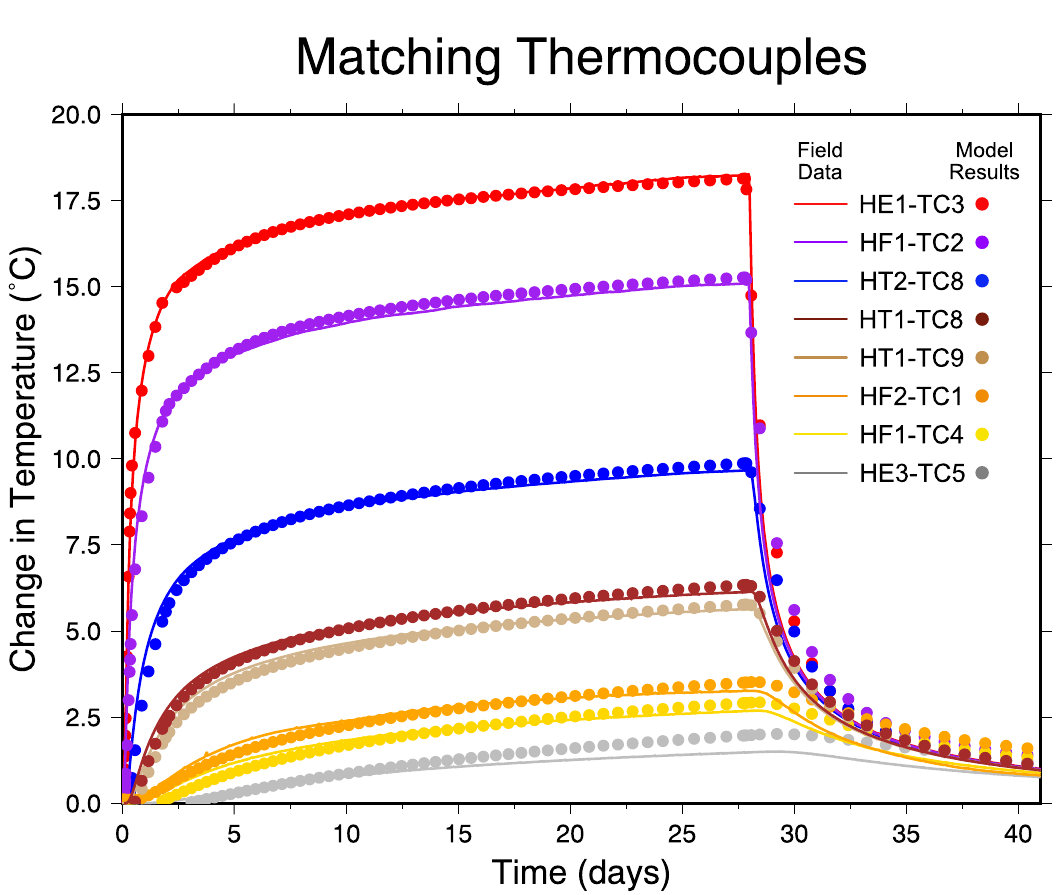
Figure 9. Numerical modeling results for change in temperature at three thermocouples in-plane with the heater over time. The solid lines represent the temperature measured in the field and the dots represent the modeled temperature at each